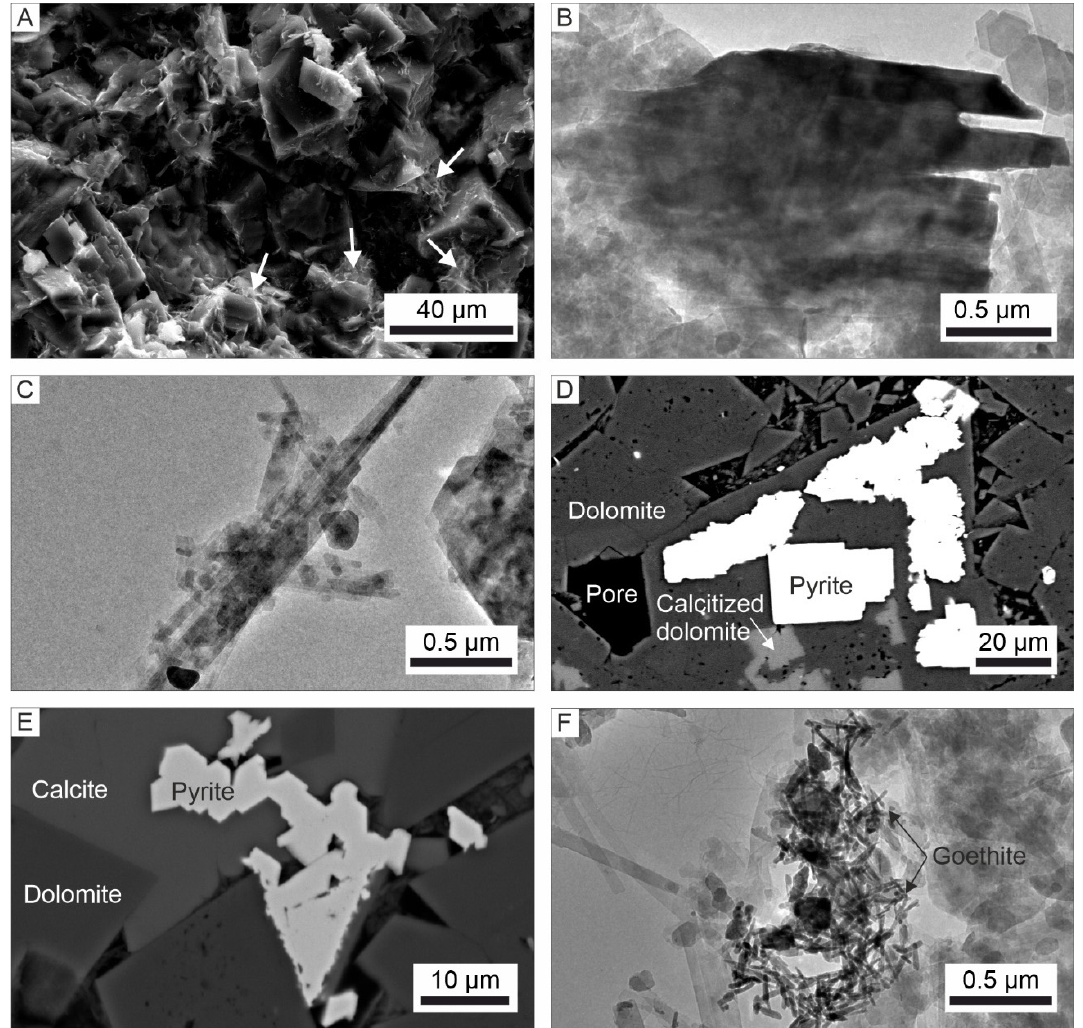
Figure 5. SEM and TEM images of the non-carbonate fraction of Dolomite 2a and 2b in the Casablanca-1A well. ( A ) SEM microphotograph of Dolomite 2b coated by flaky particles of illite (white arrows). ( B ) TEM microphotograph of an irregular flaky particle of illite. ( C ) TEM microphotograph of lath-shaped crystals of illite in Dolomite 2B. ( D ) SEM microphotograph of pyrite placed within growth cavities of dolomite. ( E ) SEM microphotograph of pyrite disseminated between dolomite crystals. ( F ) TEM microphotograph of goethite crystals within reddish Dolomite 2b.